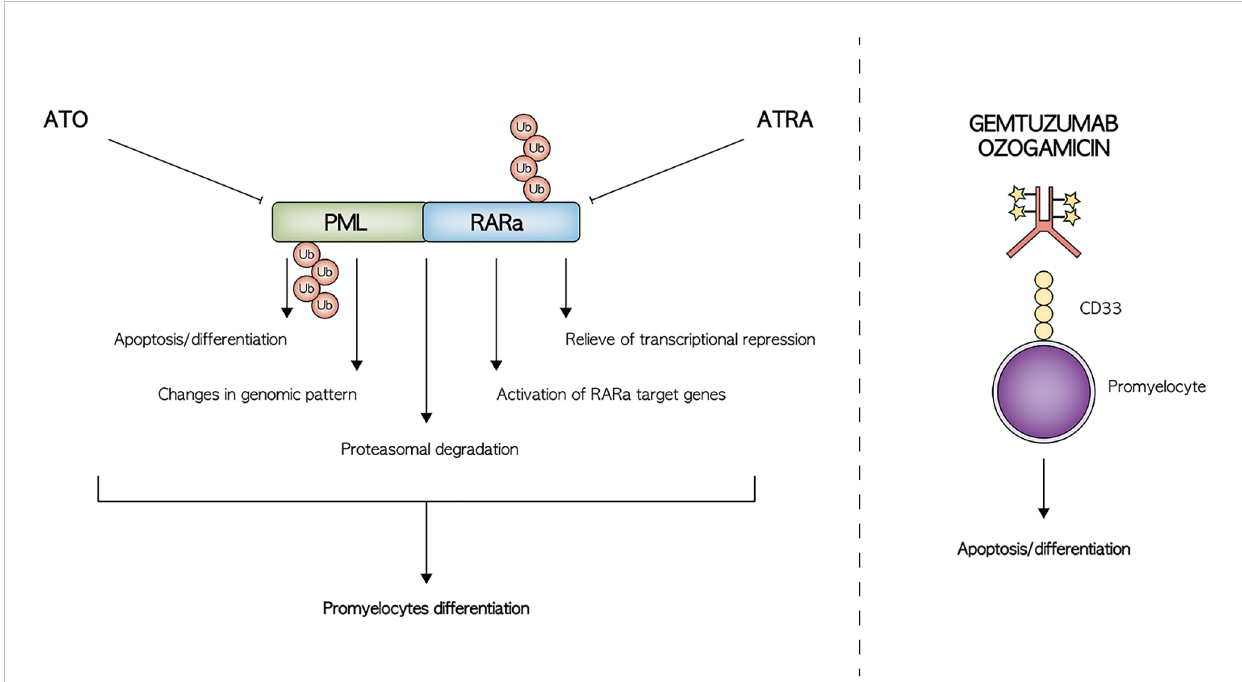
FIGURE 1 Schematic representation of the mechanism of action of the main drugs employed in the treatment of